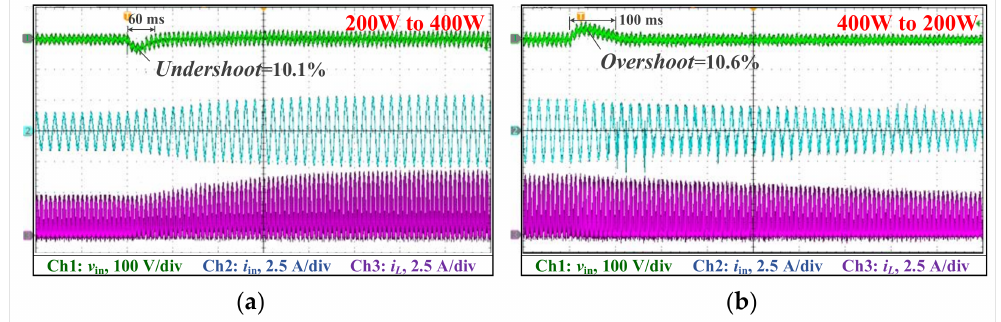
Figure 15. Dynamic responses under load steps ( a ) from 200 W to 400 W; ( b ) from 400 W to 200